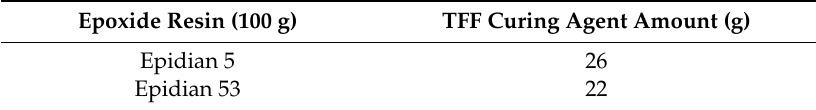
Table 2. Amount of the TFF curing agent recommended by the supplier and used in the study per 100 g of the epoxide resin [44].